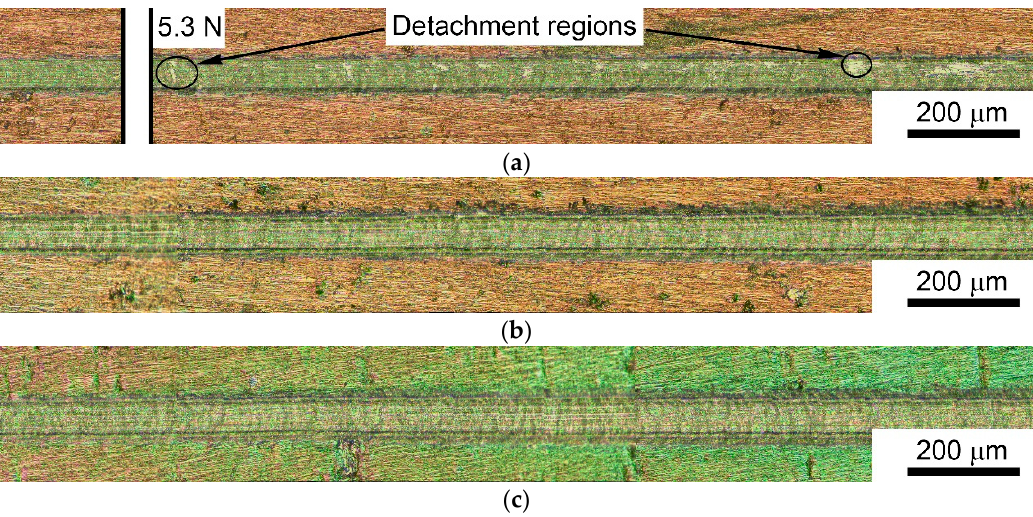
Figure 10. Optical microscopy of the tracks after scratch testing of the CaP coatings deposited on Ti at a working gas pressure of 0.8 mTorr under inclination angles of 0° ( a ), 60° ( b ), and 80° ( c ). Local detachment of the coating is seen on the side of the track and in several other regions that are identified by arrows in Figure 10a. We concluded that the coating demonstrates sufficient scratch resistance, which is in accordance with the scientific data available in the literature [60,61]. In contrast, samples deposited at inclinations of 60° and 80° (Figure 10b,c) show higher scratch resistance. Thus, coating delamination even at the maximum load of 10 N is not observed. The average value of the friction coefficient for both the tilted substrates during the measurements did not exceed 0.25. This fact also contributed to the observed, improved scratch resistance of the tilted samples. We associate